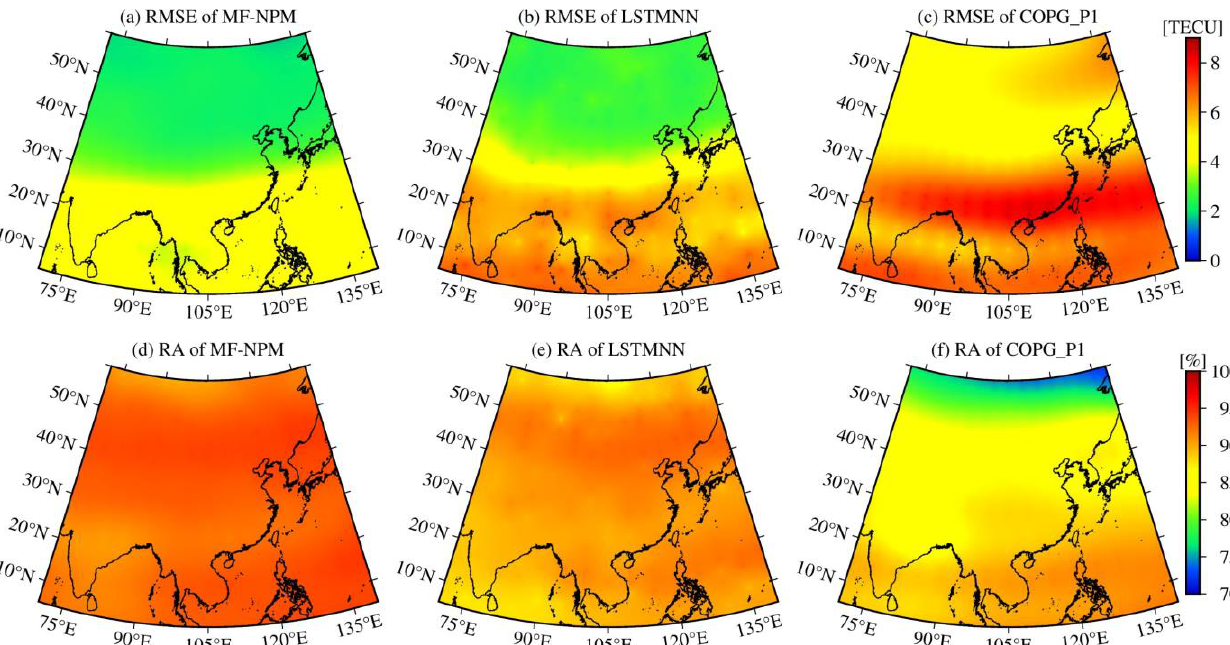
Figure 10. The 2D spatial distributions of ( a – c ) RMSE and ( d – f ) relative accuracy for MF-NPM, LSTMNN, and COPG_P1 during geomagnetic storms.